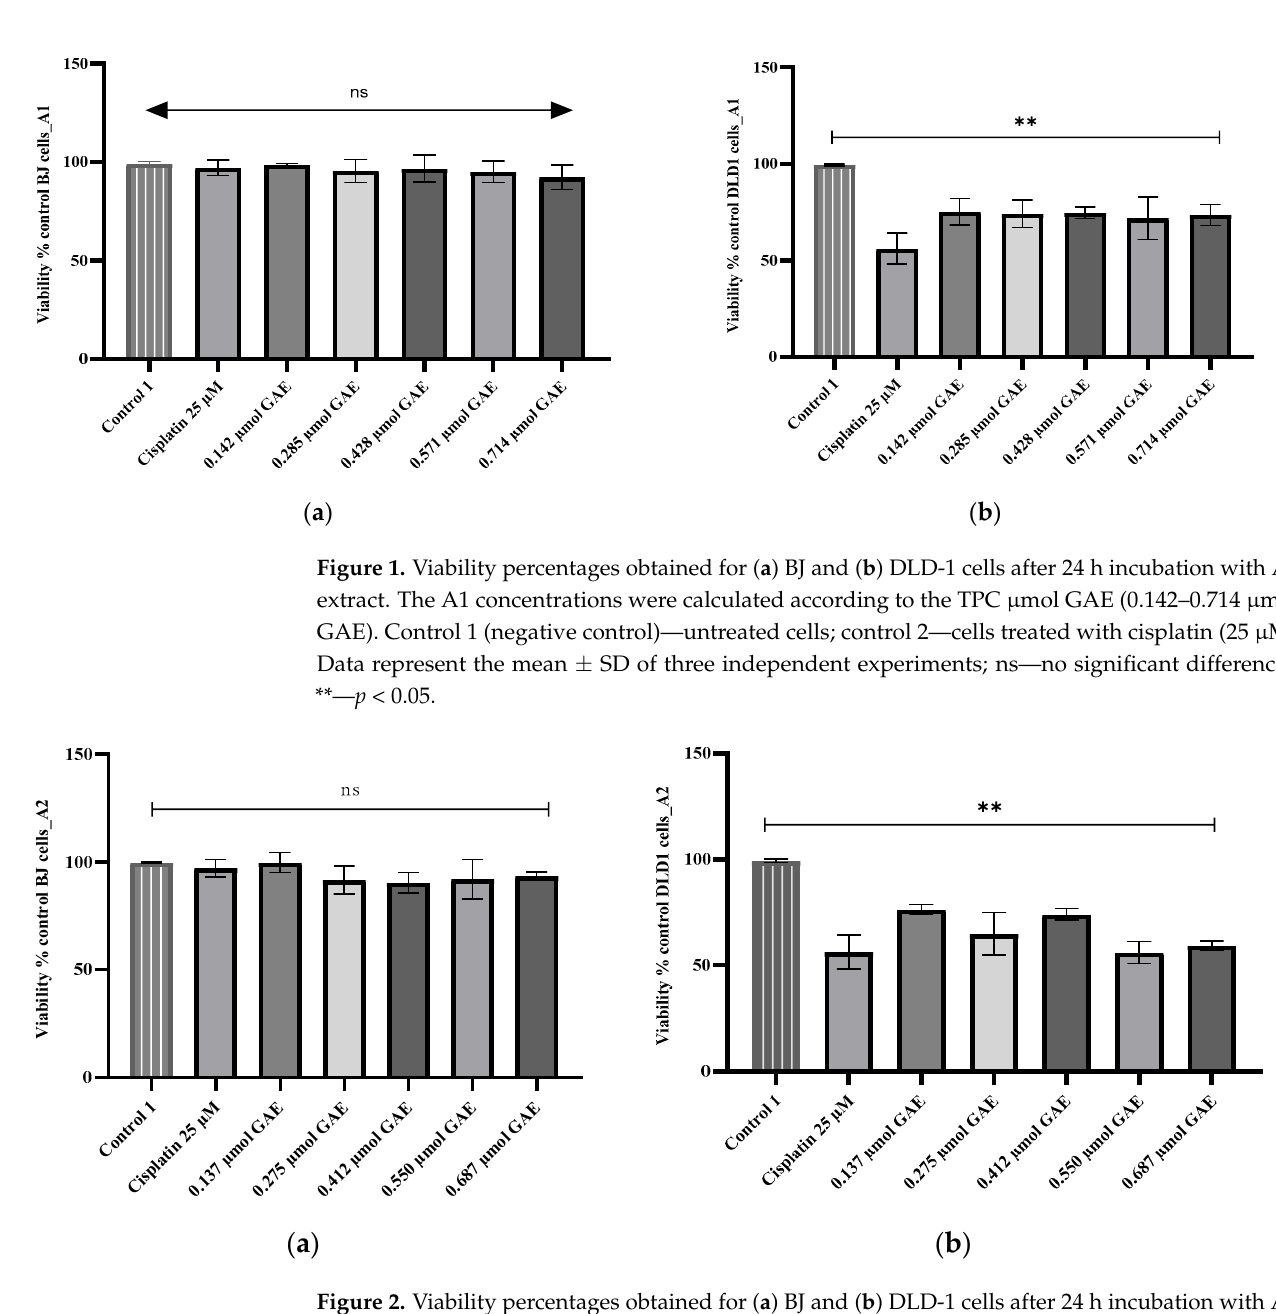
Figure 2. Viability percentages obtained for ( a ) BJ and ( b ) DLD-1 cells after 24 h incubation with A2 extract. The A2 concentrations were calculated according to the TPC µmol GAE (0.137–0.687 µmol GAE). Control 1 (negative control)—untreated cells; control 2—cells treated with cisplatin (25 µM). Data represent the mean ± SD of three independent experiments; ns—no significant differences; **— p < 0.05.